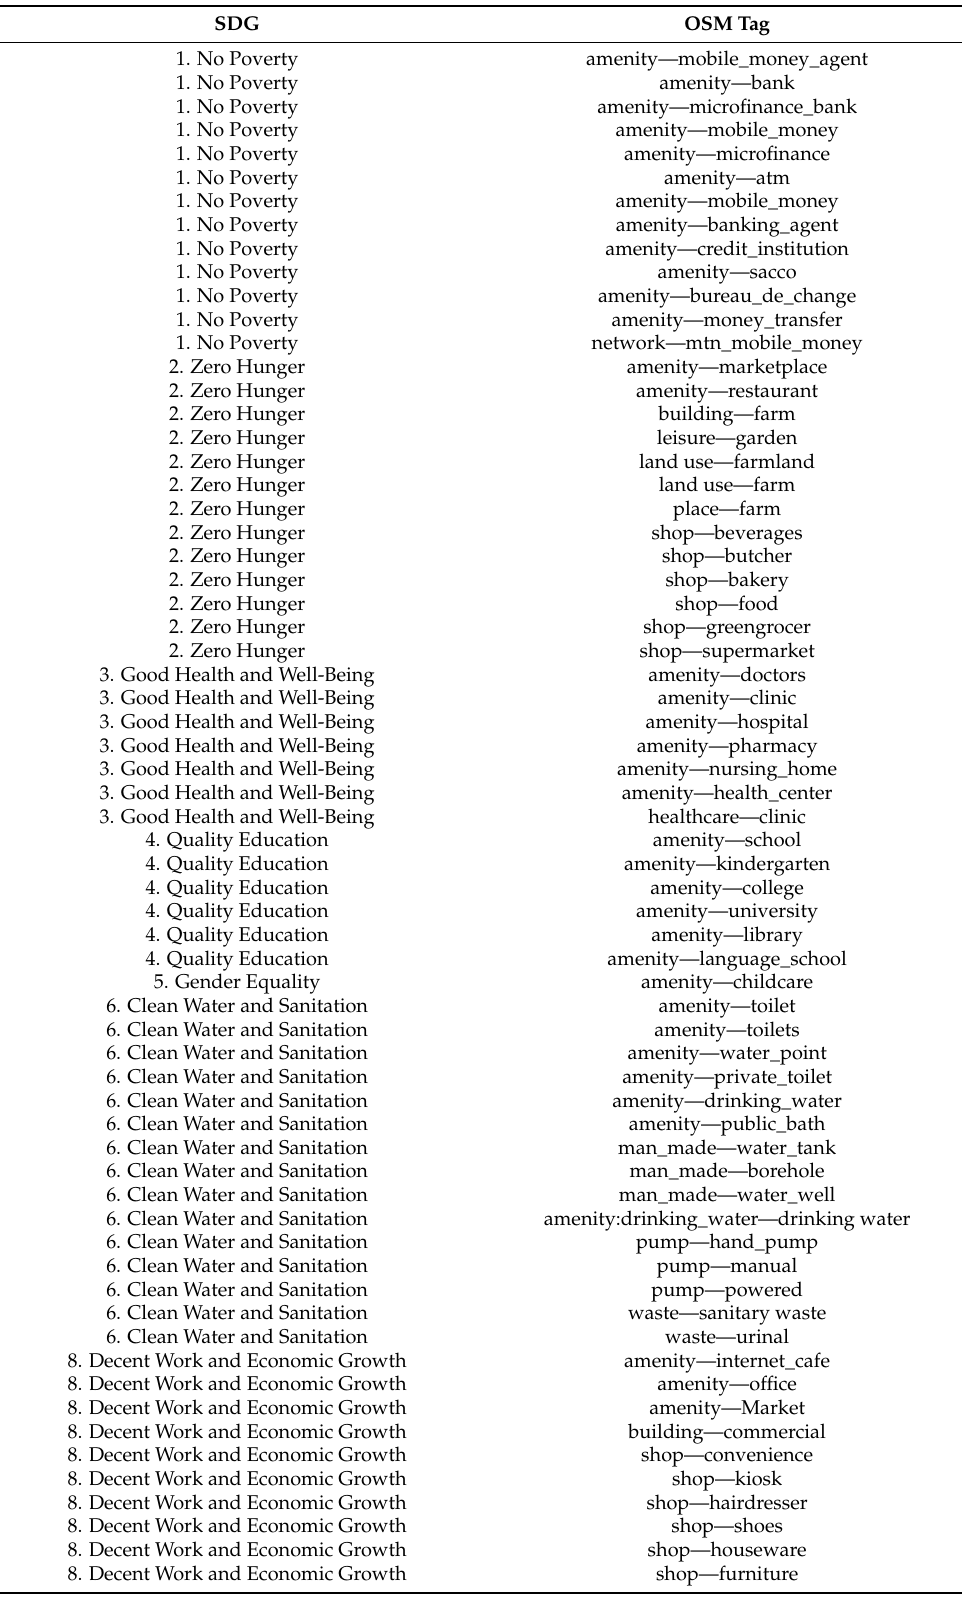
Table A1. SDG-OSM data model. OSM tags are shown as “key—value” pairs. SDG OSM Tag 1. No